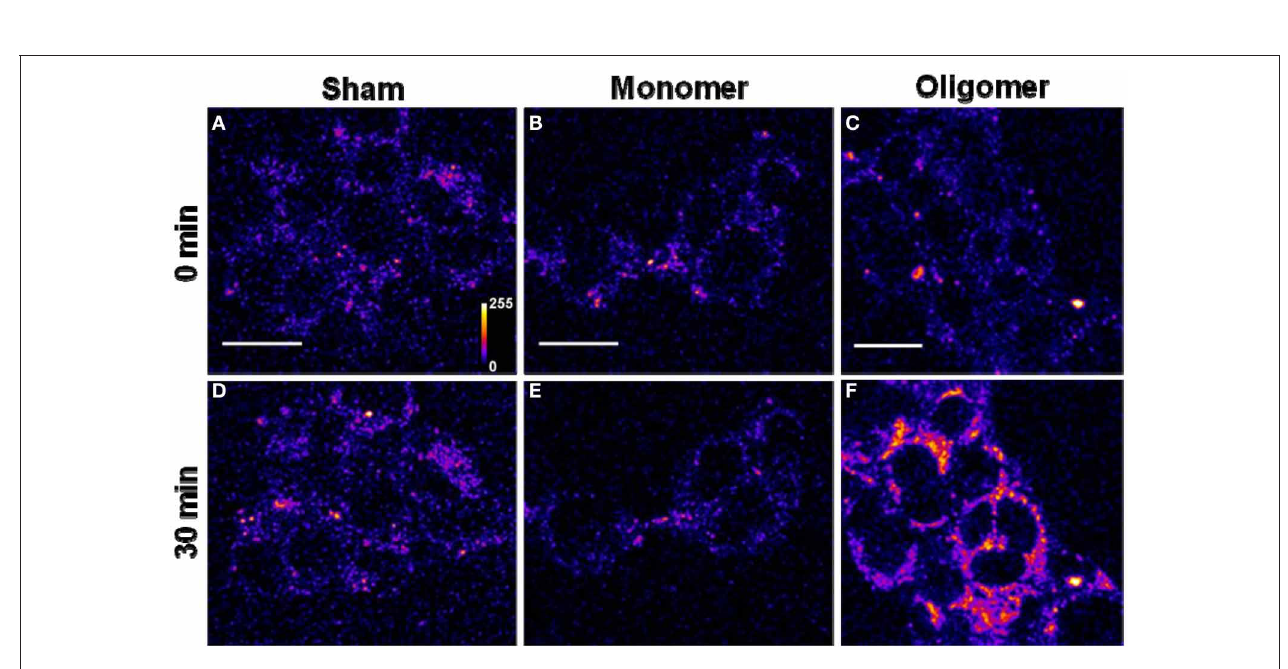
FIGURE A2 | Binding of A β 40 monomers and oligomers toHEK293Tcellmembranes.(A–C) Confocalsectionsofthreesetsof cells (excitation 543nm, emission 550–700nm). (D–F) Corresponding